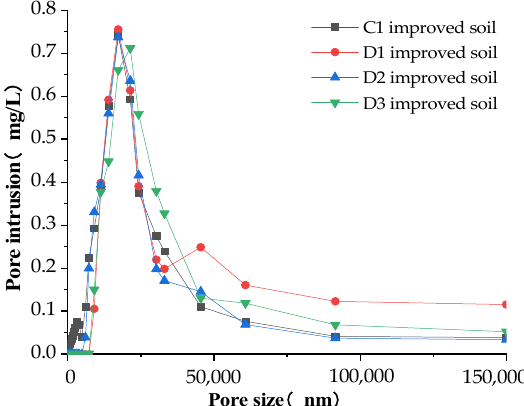
Figure 10. Pore distribution of soil amended with ameliorants.